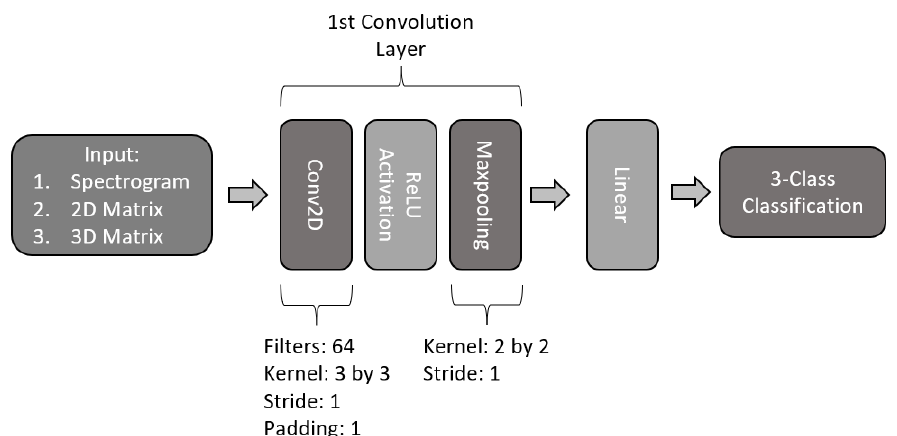
Figure 11. Architecture of single CNN model.